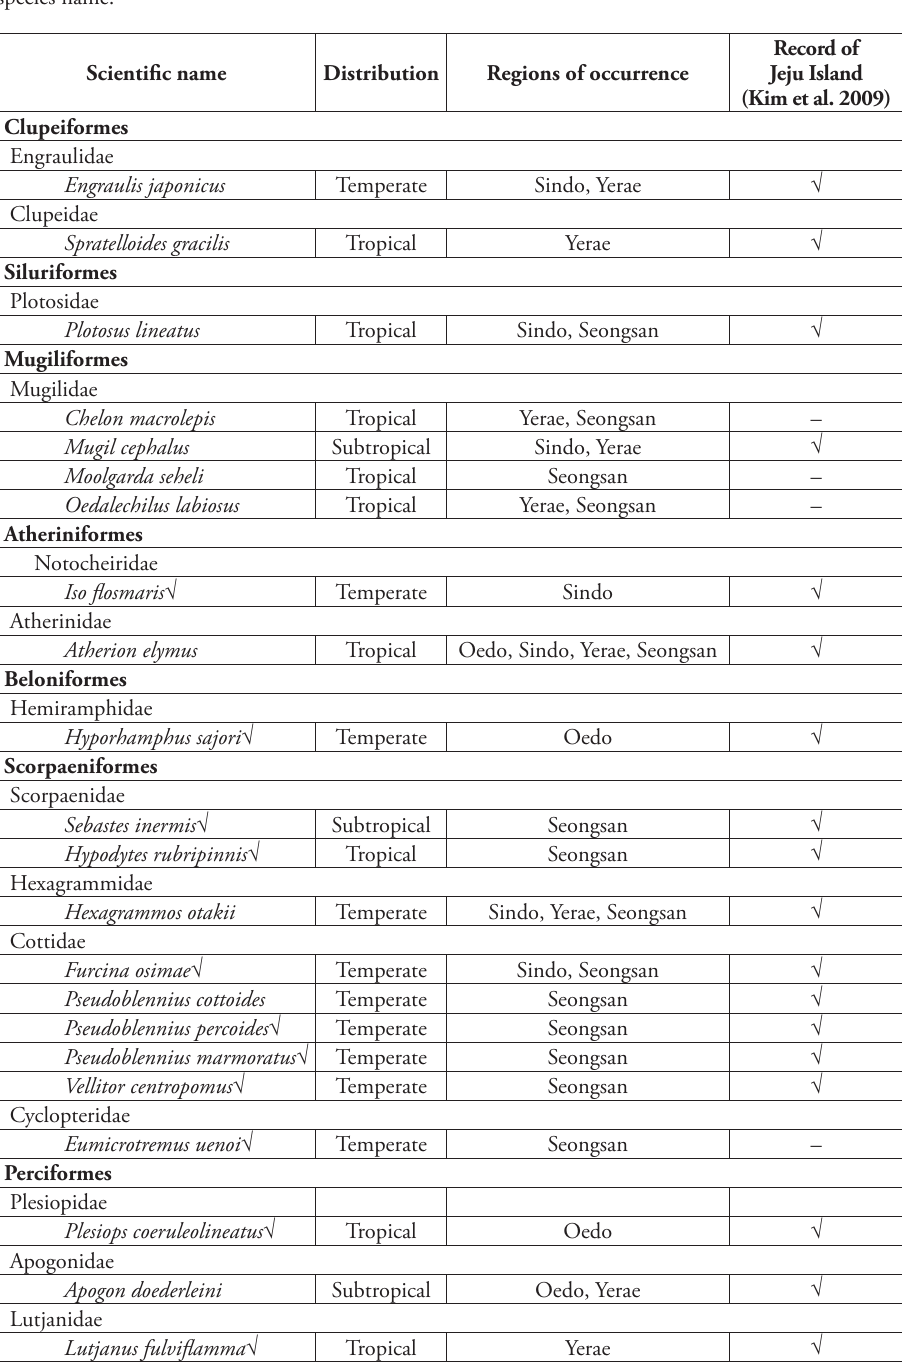
Table 1. Tidal pool fishes in Jeju Island, Korea. New records in this paper indicated with a tick after the species